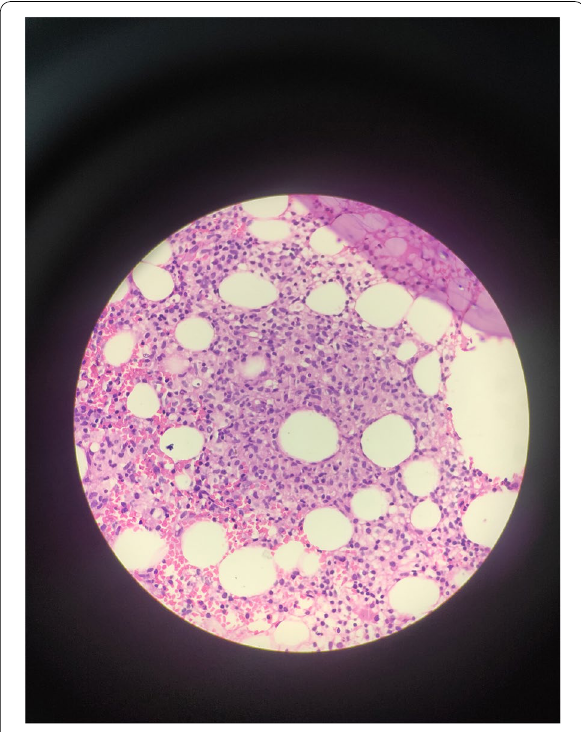
Fig. 1 Few ill-defined and well-defined confluent epithelioid cell granuloma with no necrosis amidst reactive cellular